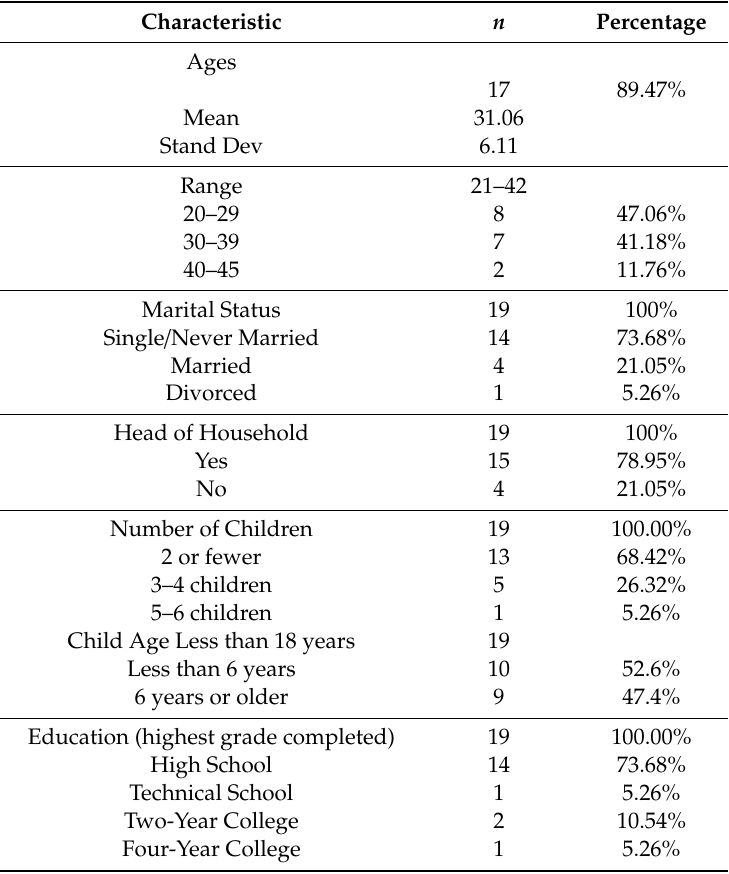
Table 1. Frequency distribution of selected demographic variables ( n =